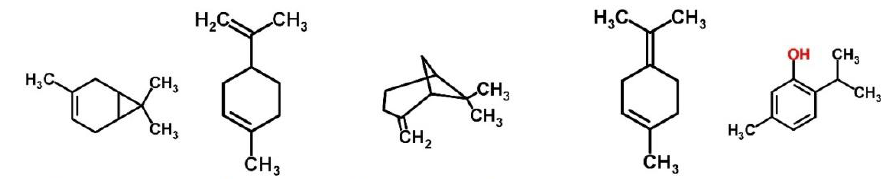
Figure 2. Chemical structures of the five most active test compounds that were used in semi-field bioassays.